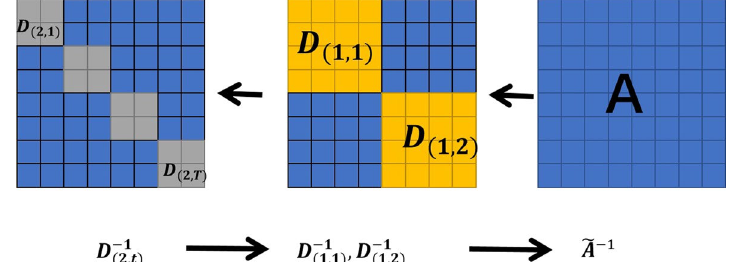
Fig. 9 Block matrix approximation of